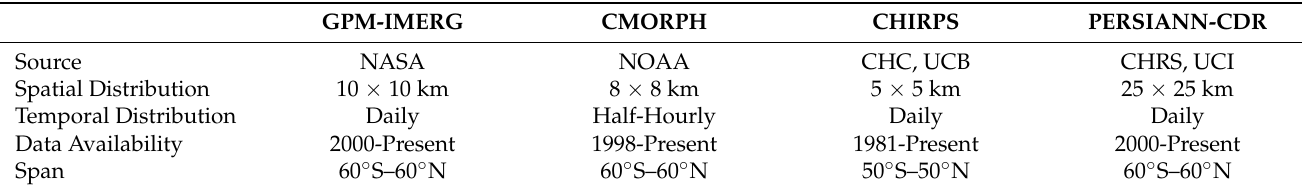
Table 1. Details of the utilized remotely sensed satellite precipitation products with their spatial and temporal resolutions and source. GPM-IMERG CMORPH CHIRPS